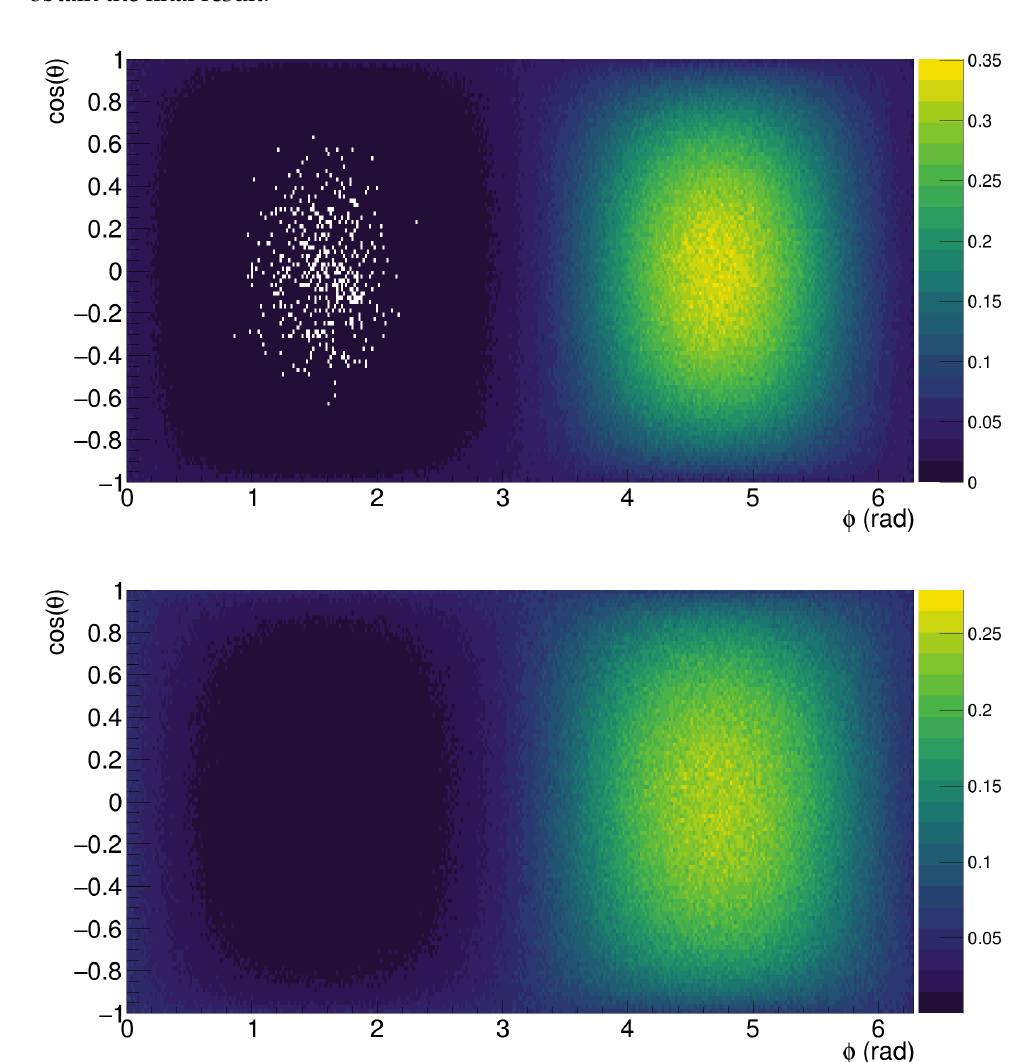
Figure 12. Two examples of the angular distribution of recoils due to DM in Galactic coordinates, obtained by Monte Carlo simulations. Top: helium recoils induced by 10 GeV/c 2 DM. Bottom: fluorine recoils induced by 100 GeV/c 2